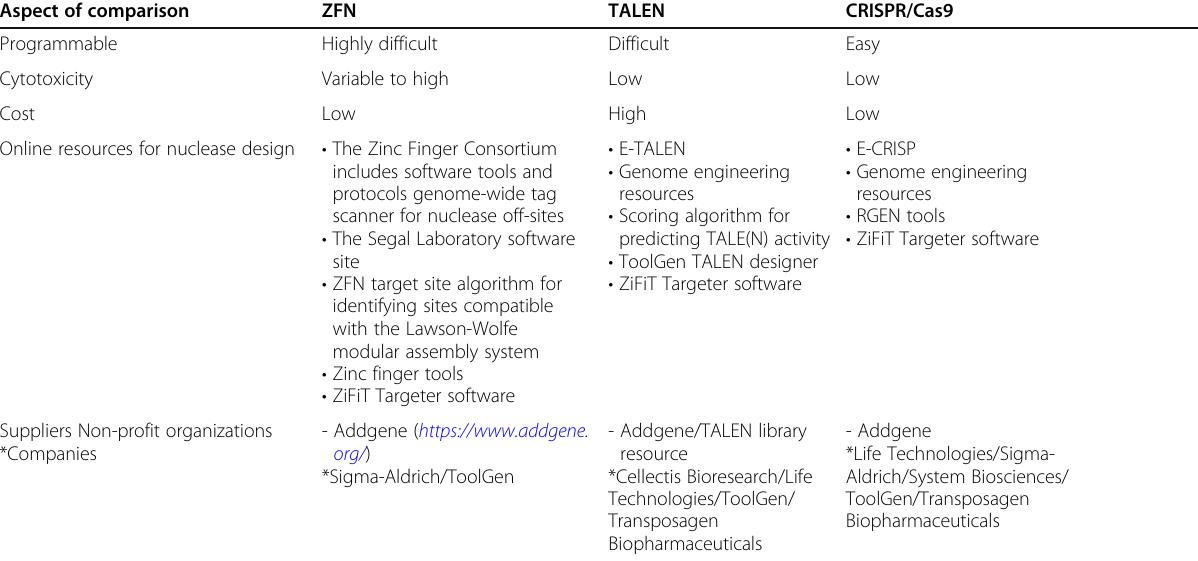
Table 1 Comparison of the three main currently used genome engineering platforms: ZFN, TALEN, and CRISPR/Cas9* (Continued) Aspect of comparison